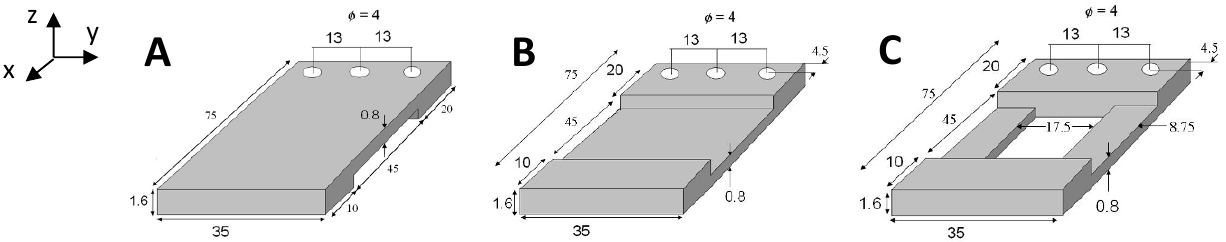
Figure 8. Configuration of the three cantilevers (all dimensions are in mm).